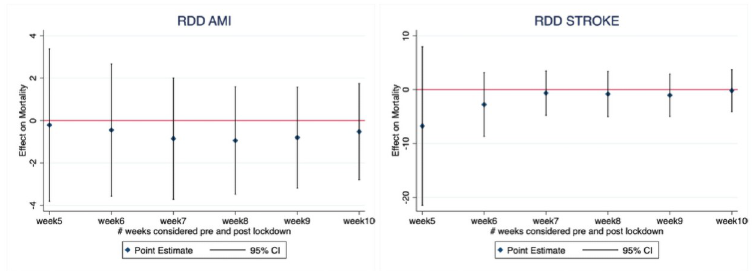
Fig 2. Coefficient (95% CI) indicating mortality differences across various time windows following implementation of the COVID-19 lockdown (March, 9 th 2020) versus mortality in similar time windows preceding the measures in 2020. Estimates derived from regression-discontinuity design adopting a Firth logit model.